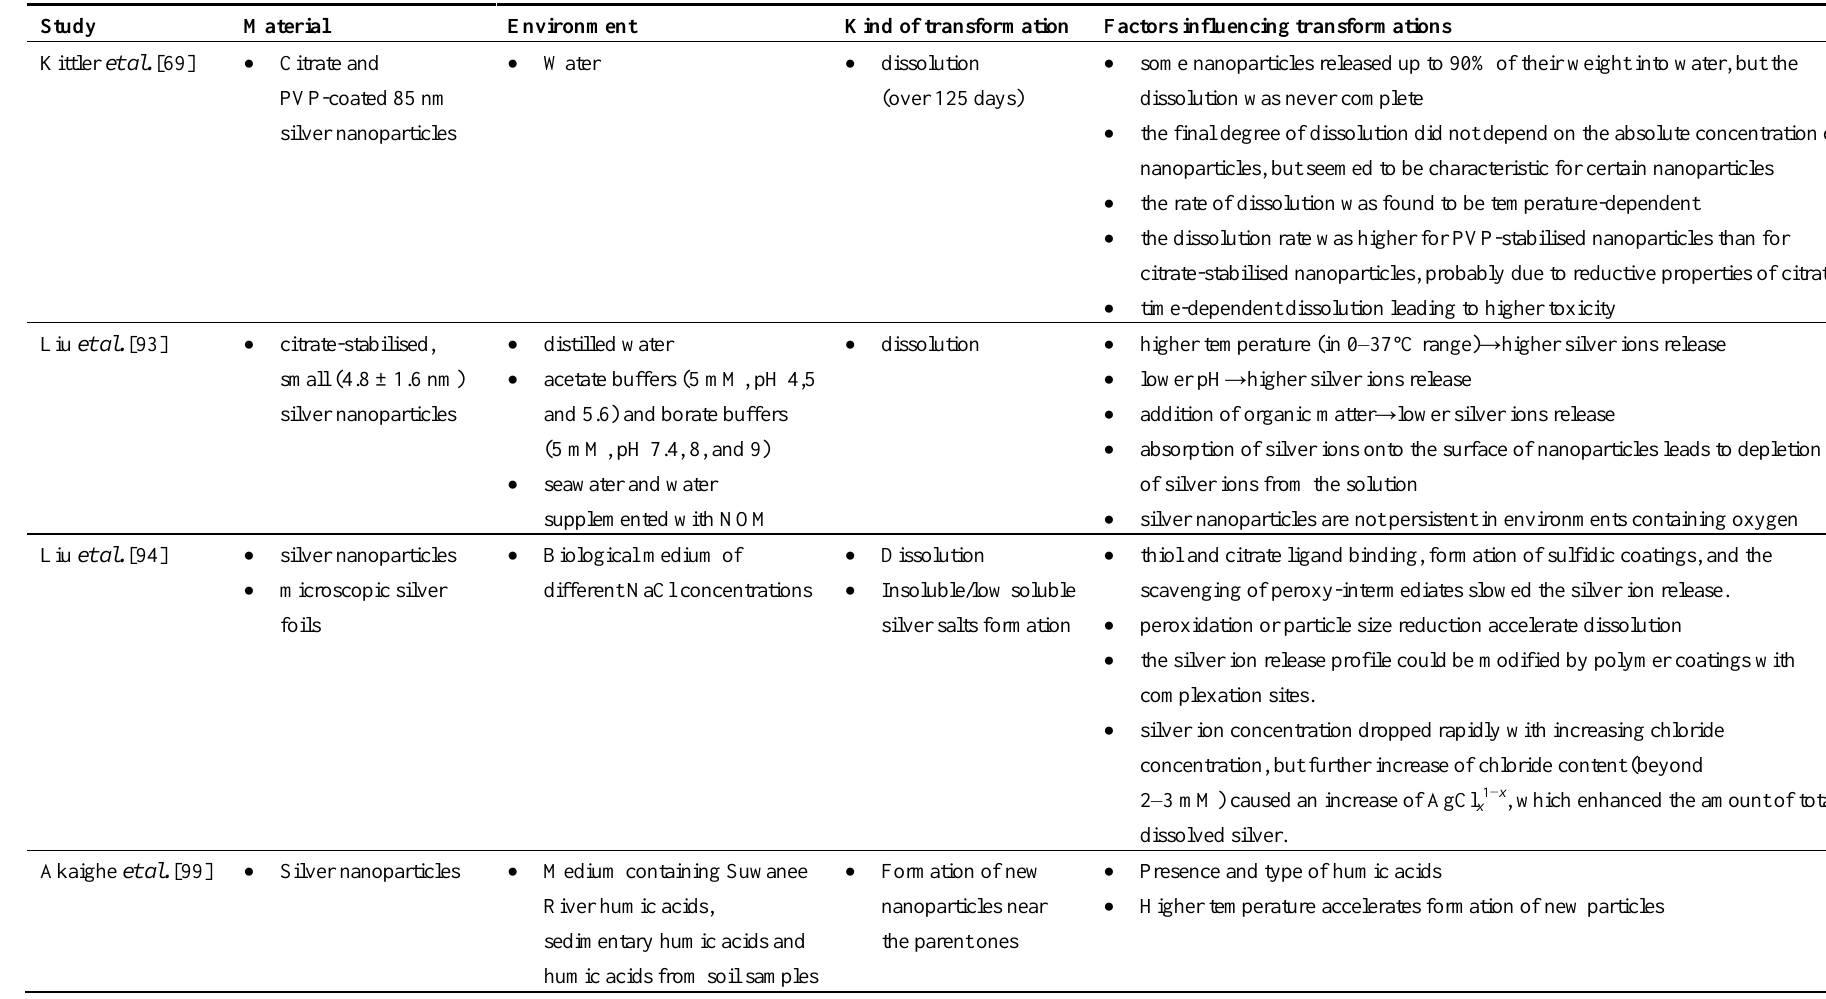
Table A1. Transformation of silver nanoparticles in the